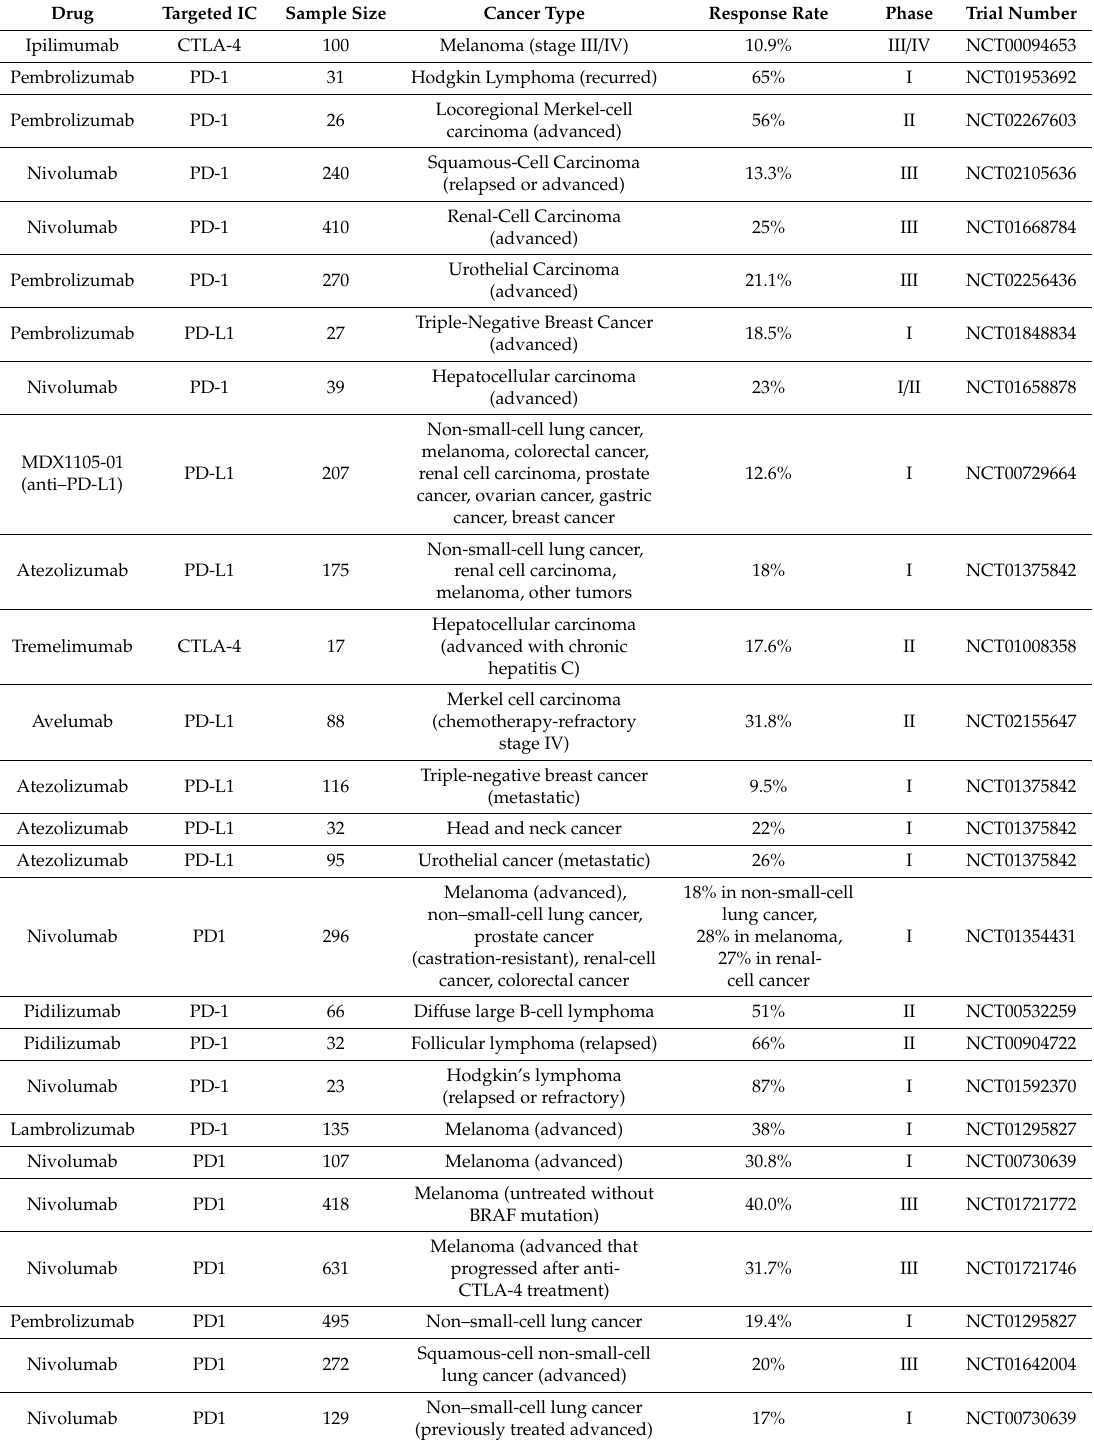
Table 2. Active clinical trials of immune checkpoint blockade for novel oncological indications.